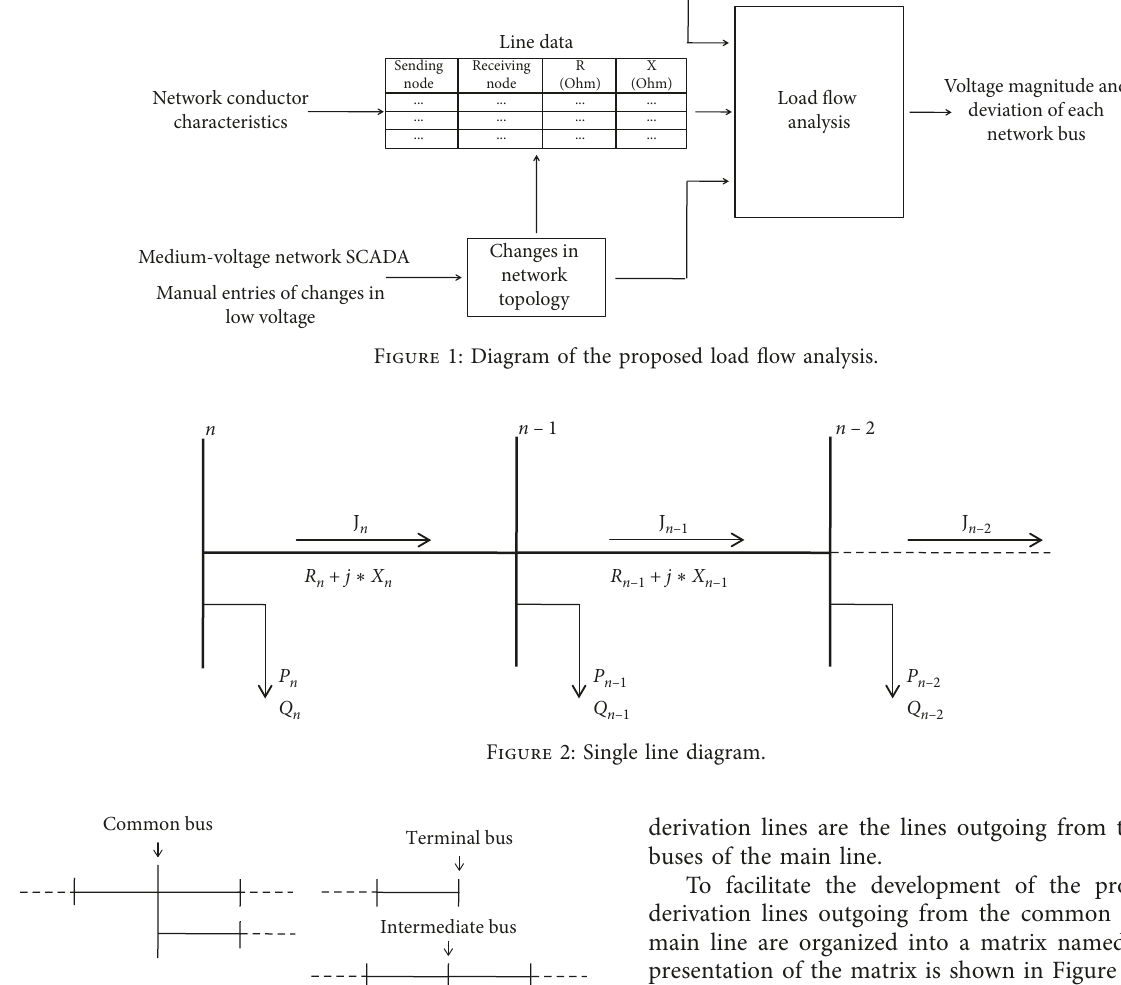
Figure 3: Types of network